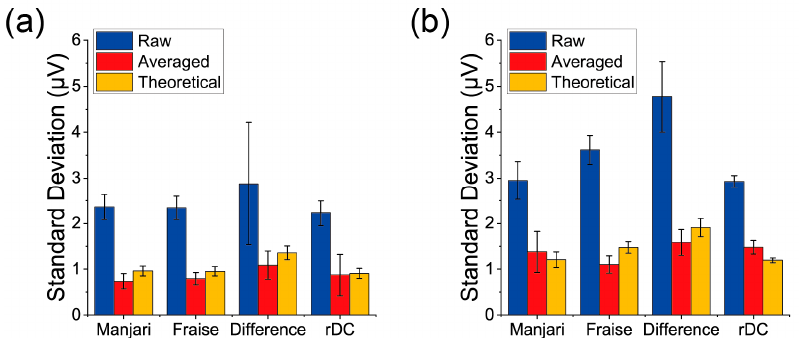
Figure 5. Summary of the noise level of each measurement with ( a ) the PPPO-coated MSS and ( b ) the PS-coated MSS. Error bars represent the standard deviations.